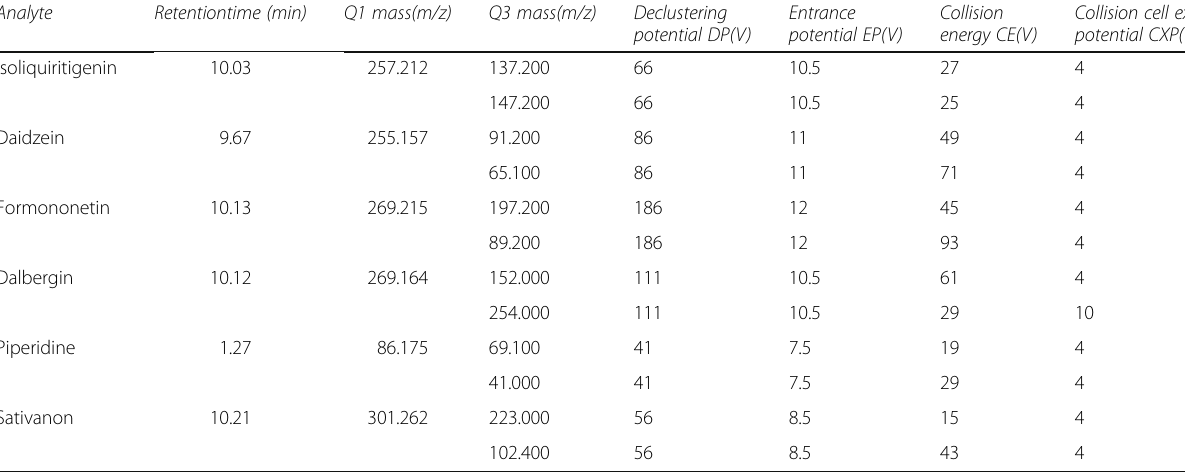
Table 1 LC-MS/MS parameters for quantitation and confirmation Analyte Retentiontime